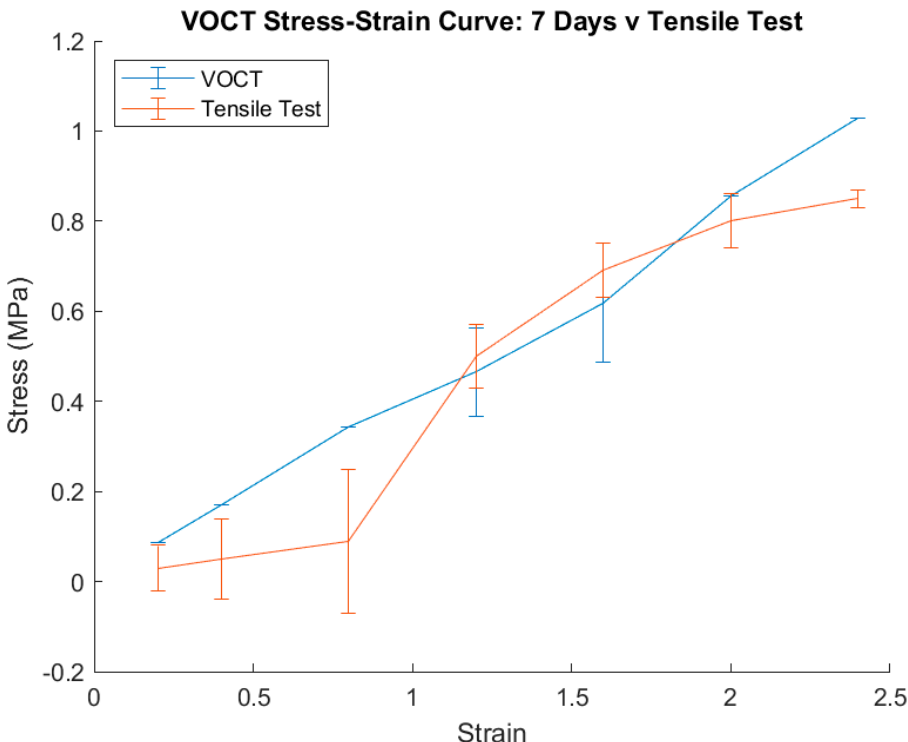
Figure 3. Tensile and VOCT stress–strain curves for silicone specimens cured for 7 days. VOCT stress–strain data was back-calculated using the modulus obtained using the resonant frequency and incremental strain values taken during tensile testing of the specimens cured for 7 days.